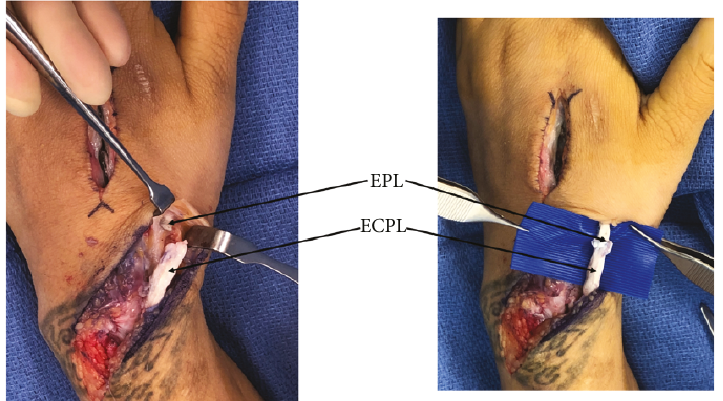
Figure 6: EPL reconstruction. We reconstructed the EPL tendon using an end-to-end tendon transfer from the